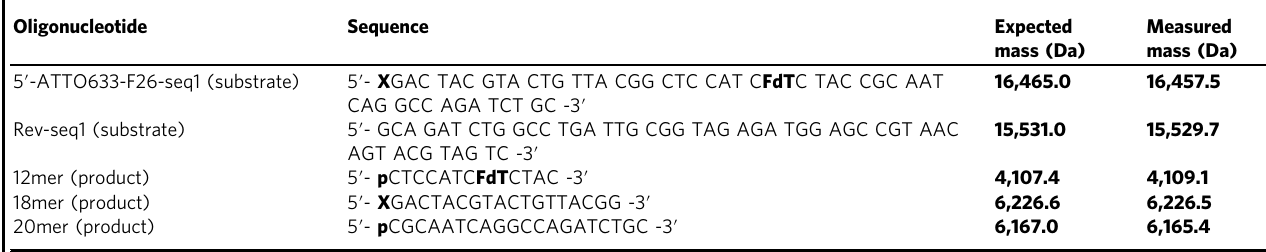
Table 1 Expected and measured masses of DNA fragments after processing of F26-seq1 by drUvrABC. Oligonucleotide